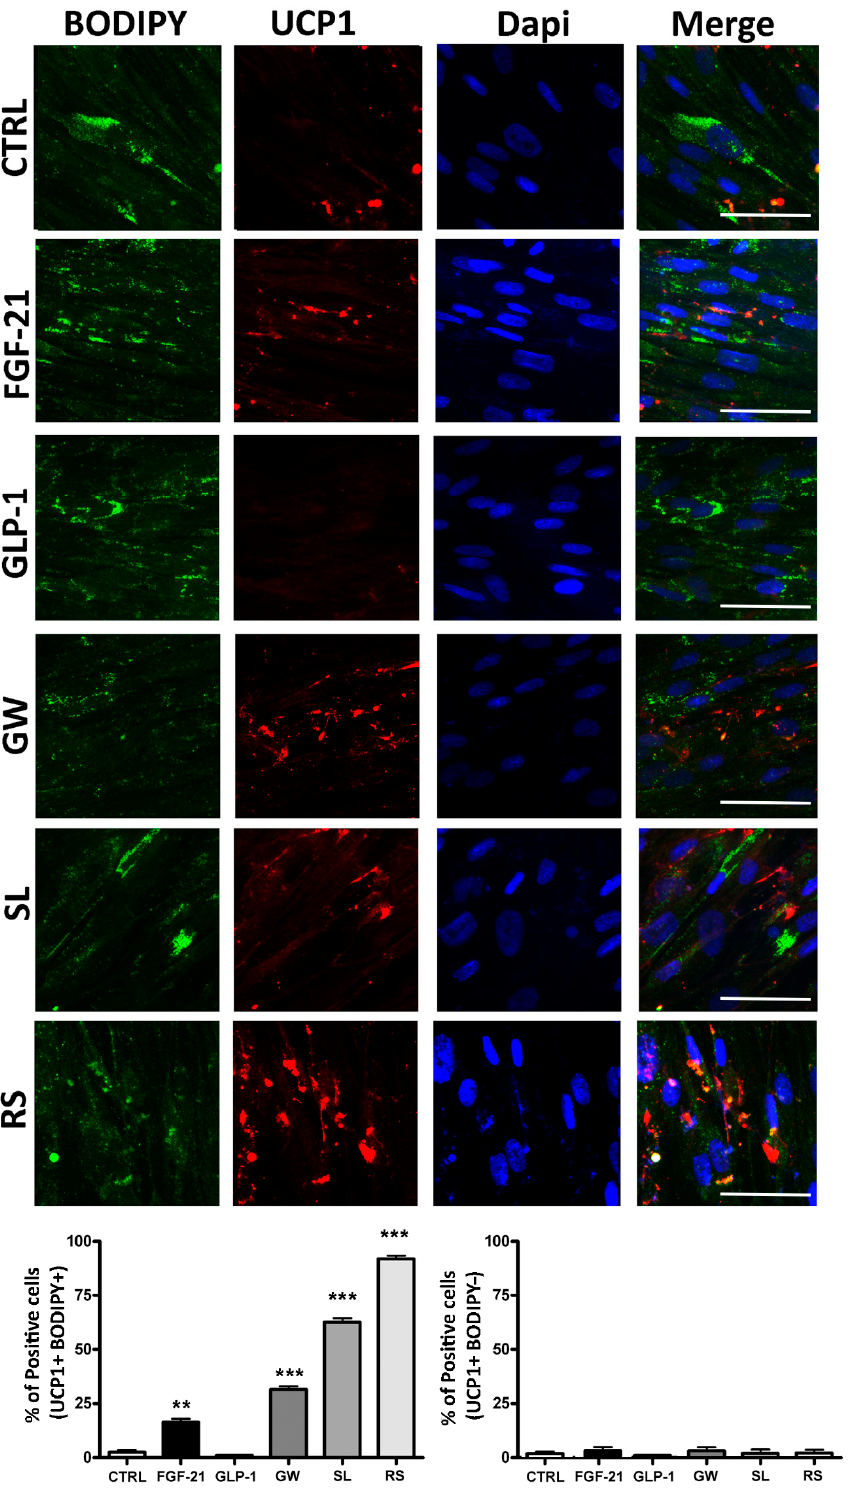
Figure 5. Expression of thermogenin UCP1 protein by immunocytochemistry analysis in MSCs treated with browning agents during white adipogenic differentiation. Cells were counterstained with DAPI and BODIPY 505/515 for the identification of nuclei and lipid depots, respectively. Scale bar: 100 µ m. The histograms reveal the percentage of UCP1-positive cells by counting a minimum of 500 cells in different microscope fields ( ± SD, n = 5 biological replicates; ** p < 0.01, *** p < 0.001). The left graph shows the percentage of UCP1 and BODIPY-positive cells. The right graph indicates the percentage of UCP1-positive and BODIPY-negative cells. CTRL: control; FGF-21: fibroblast growth factor-21; GLP-1: glucagon-like peptide-1; GW: GW501516; SL: sildenafil; RS: rosiglitazone. For browning agent details, refer to Table